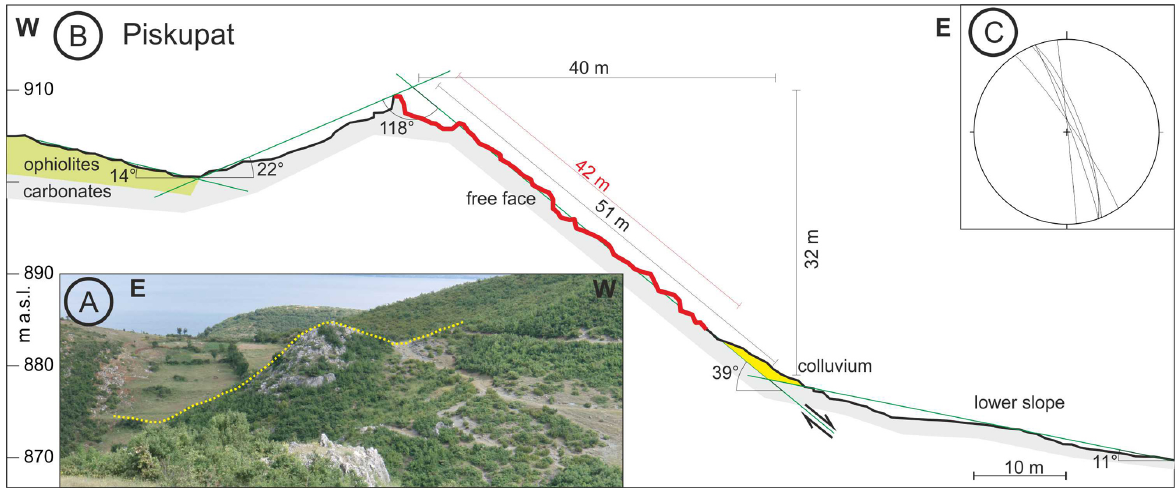
Figure 5. (A): Photograph of the Piskupat scarp. Yellow line gives the approximate position of the profile. (B): Complete profile and geo- metric reconstruction of the Piskupat fault (41°0211511N, 20°3713211E; 905 m a.s.l. for location see Figure 1). No vertical exaggeration. Green lines show constructed angles of upper and lower slope and the fault plane. Red lines indicate the free face measured in the field. The colluvium (marked in yellow) is constructed from field data. (C): Stereonet plot of measurements from the fault plane.